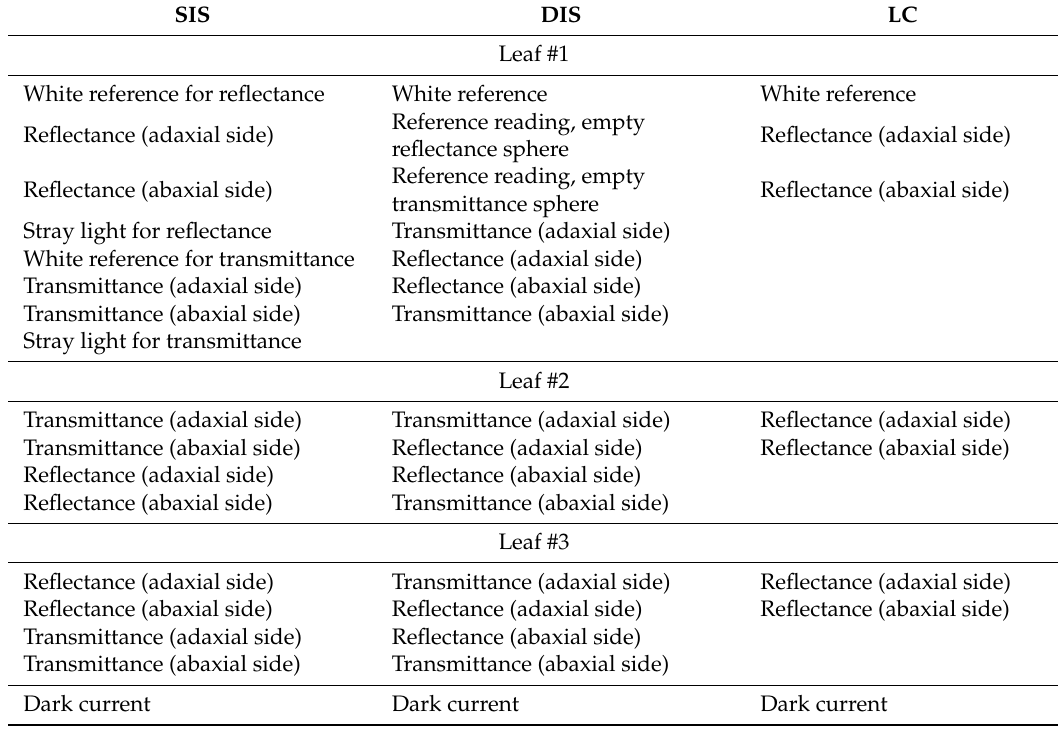
Table 2. Spectrometer readings needed for calculating reflectance and transmittance of adaxial and abaxial sides of three leaves. Note, that we performed one set of reference readings per three measured